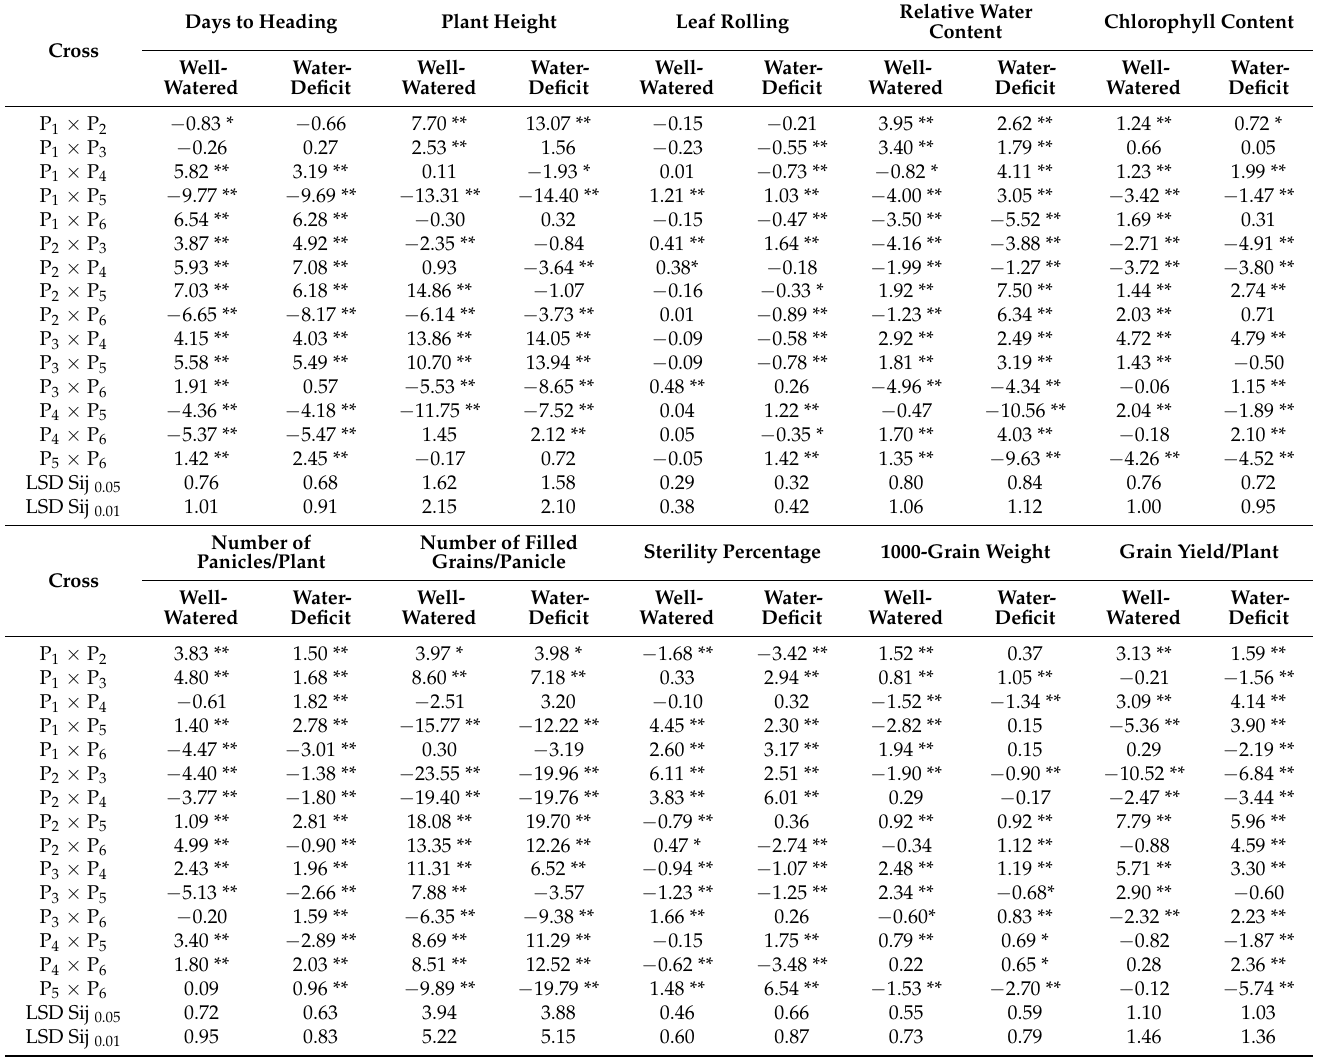
Table 4. Specific combining ability effects (SCA) of 15 F 1 cross combinations for all evaluated traits under well-watered and water-deficit